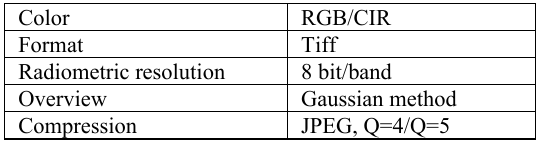
Table 1. Aerial imagery- parameters of writing Other requirements for photogrammetric imagery are similar to other European